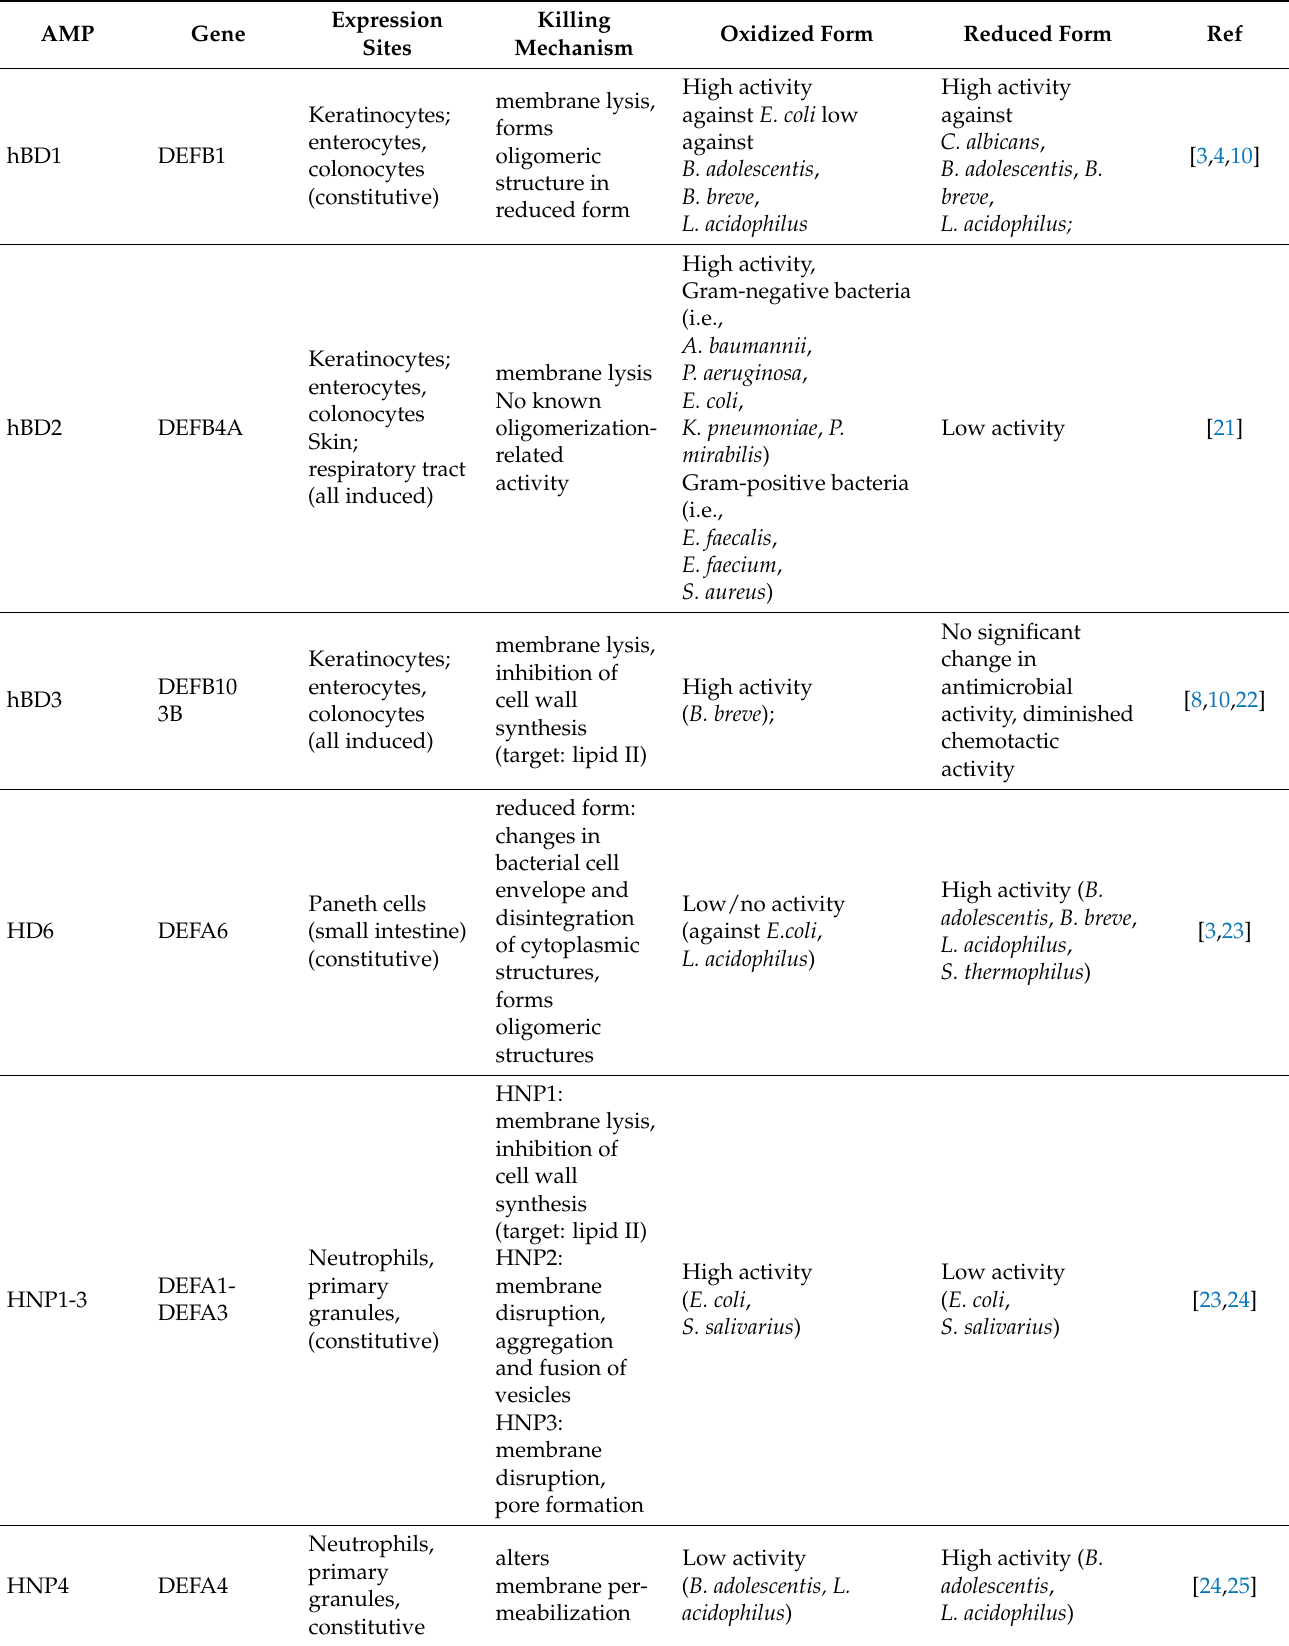
Table 1. Skin- and gut-associated AMPs that are functionally modified by cysteine-dependent redox cues.